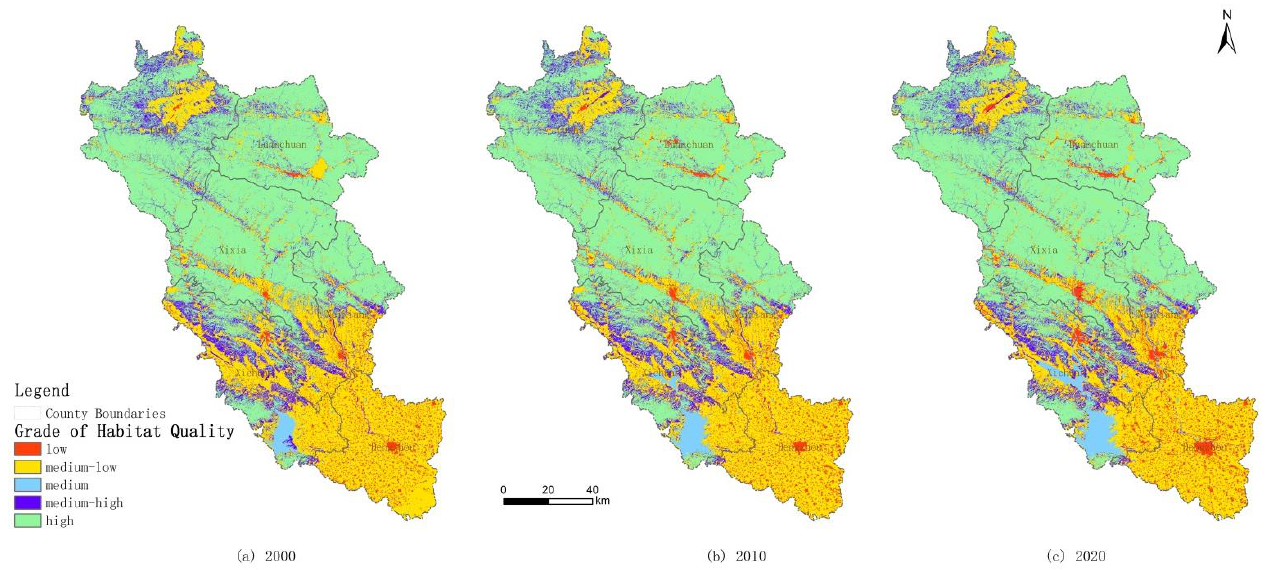
Figure 5. Spatio-temporal patterns of habitat quality.